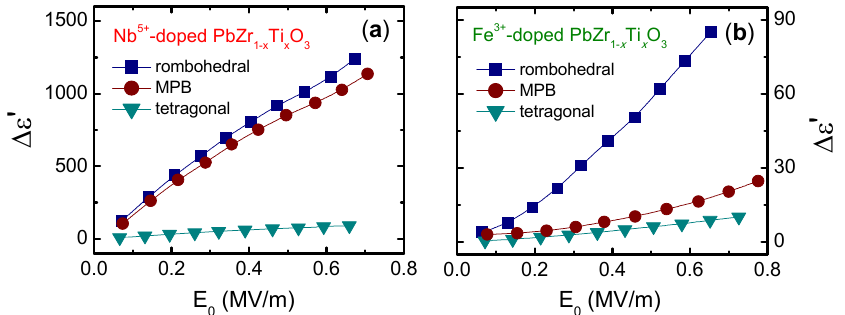
Figure 2. Increments of the dielectric constant as a function of the applied electric field amplitude for Pb(Zr 1 ‐ x Ti x )O 3 ( x = 0.40, 0.47, 0.60) doped with ( a ) softener and ( b ) hardener ions. The data were partially extracted from the reference [26] (Copyright AIP Publishing LCC., 2008).